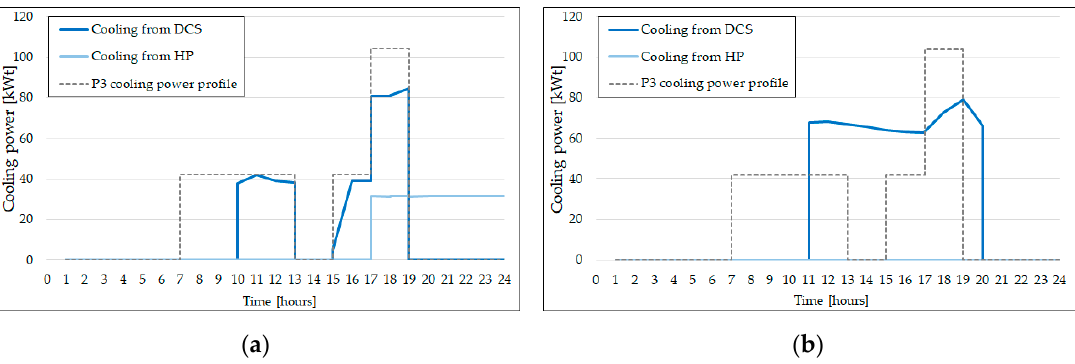
Figure 8. Daily cooling demand breakdown into the DCS and HP share in case of cooling supply profile P3: ( a ) without a TES; ( b ) in presence of a cold-water tank of 60 m 3 .